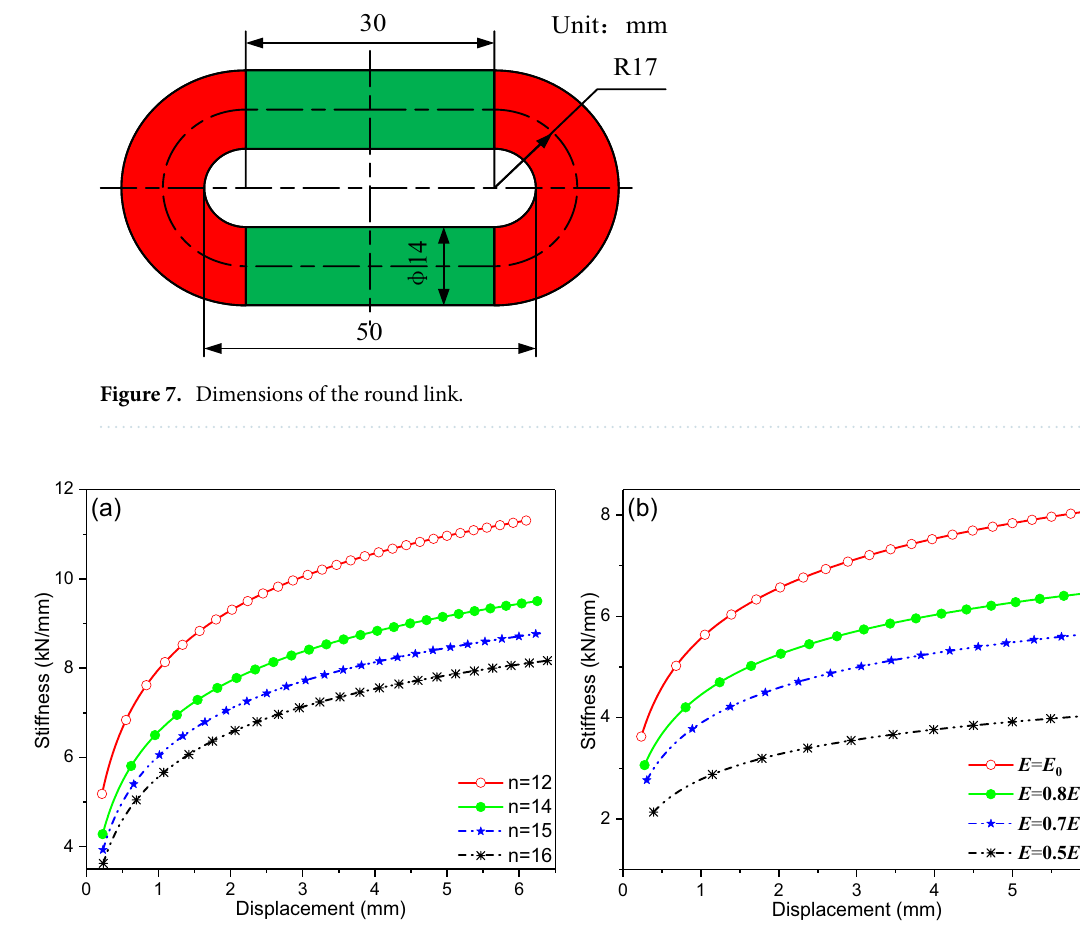
Figure 8. Parameter effects on the nonlinear stiffness, ( a ) effects of the total length and ( b ) effects of the elastic module with E 0 = 2.1 × 10 5 Mpa and n = 16.